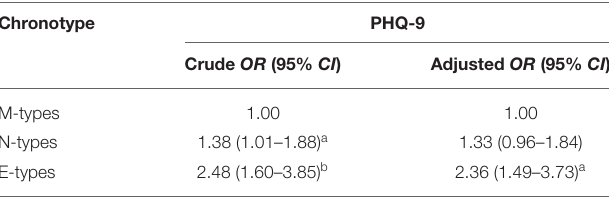
TABLE 4 | Generalized linear model analysis of chronotype and depressive